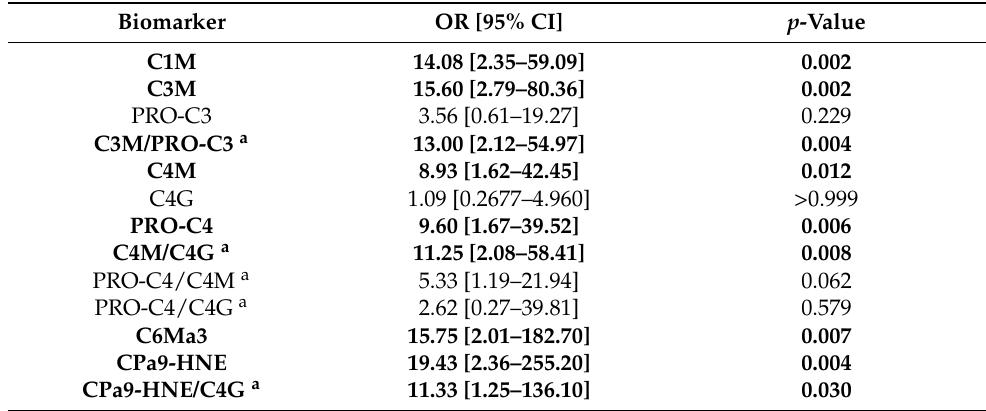
Table 4. Odds ratios (ORs) for the optimal cut-off values, determined by Youden’s J statistics on the respective ROC